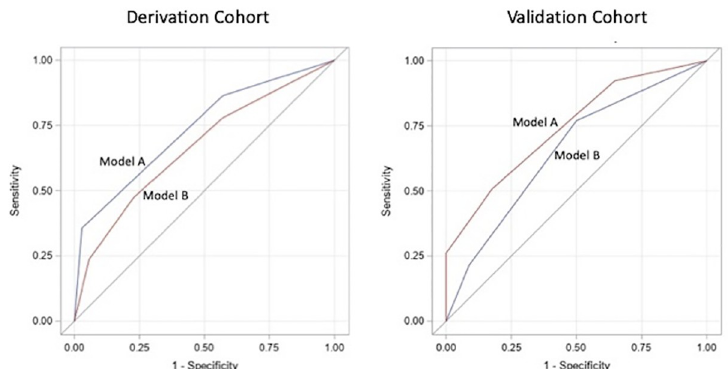
The above two ROC curves in Sample 1 were not significantly different: p = 0.24. Validation of the scoring systems. Both models were tested as predictors of in-hospital mortality in the validation cohort. In this analysis, Model A (two variables: ischemia and con- solidation) had a lower AUC than Model B (3 variables: older age, high supplemental oxygen requirement and elevated CRP): 0.65 (95% CI 0.55 to 0.76) versus 0.74 (95% CI 0.65 to 0.83), respectively, but their difference was not significant: p = 0.18. ROC curves for Sample 1 and 2 are given in Fig 1. Of note, only 107 patients could be analyzed in the logistic regression in Model A, mainly from non-existing data on troponin and no clinical diagnosis of ischemia over the first 24 hours of hospitalization. Odds ratios for each score category for both models are in Table 3 and mortality in each score category is given in Table 4.